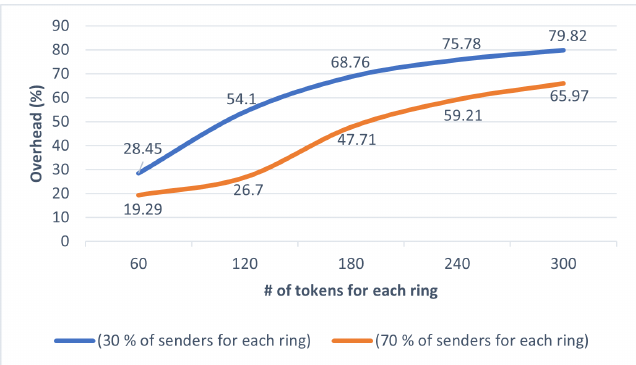
Figure 10. Overhead vs. percentage of senders in Ring2Tor .